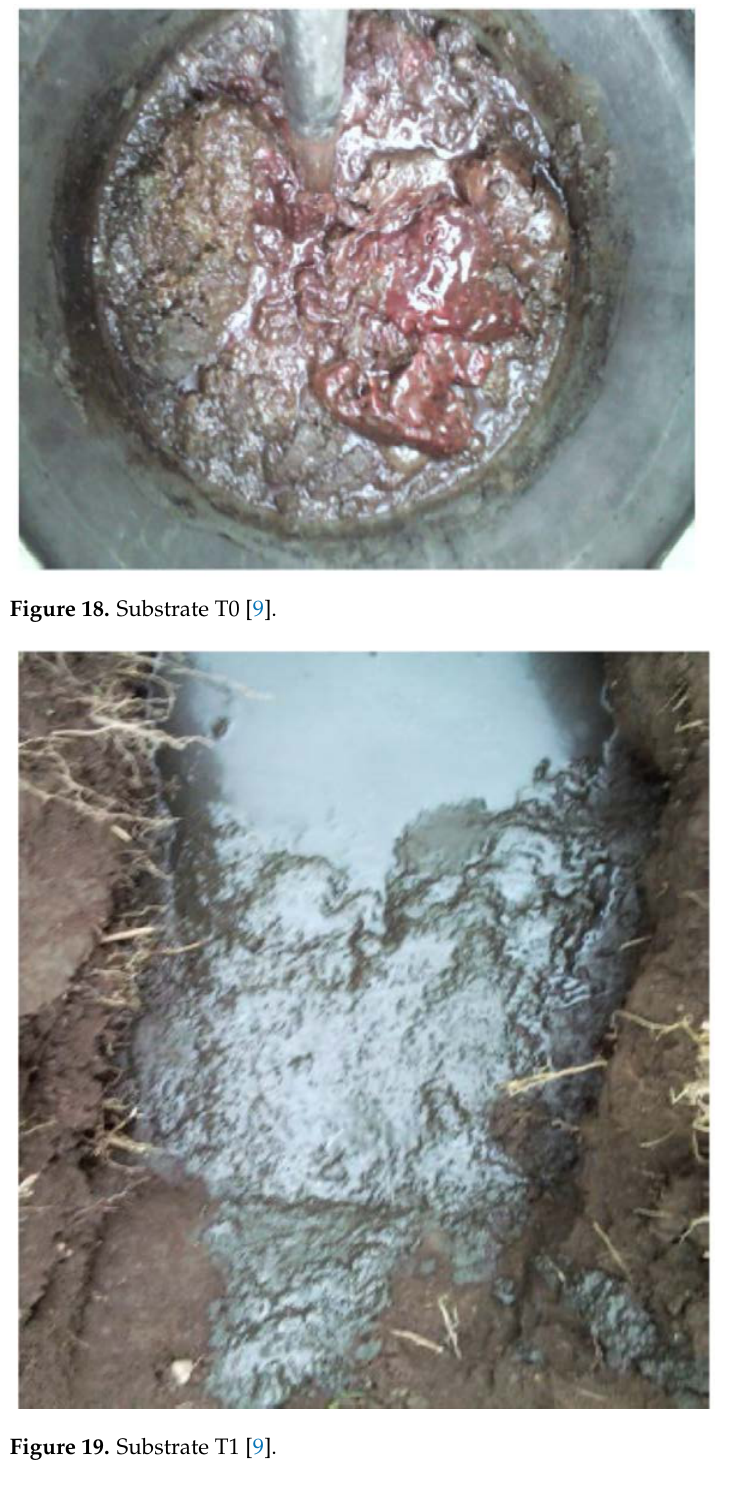
Figure 19. Substrate T1 [9].